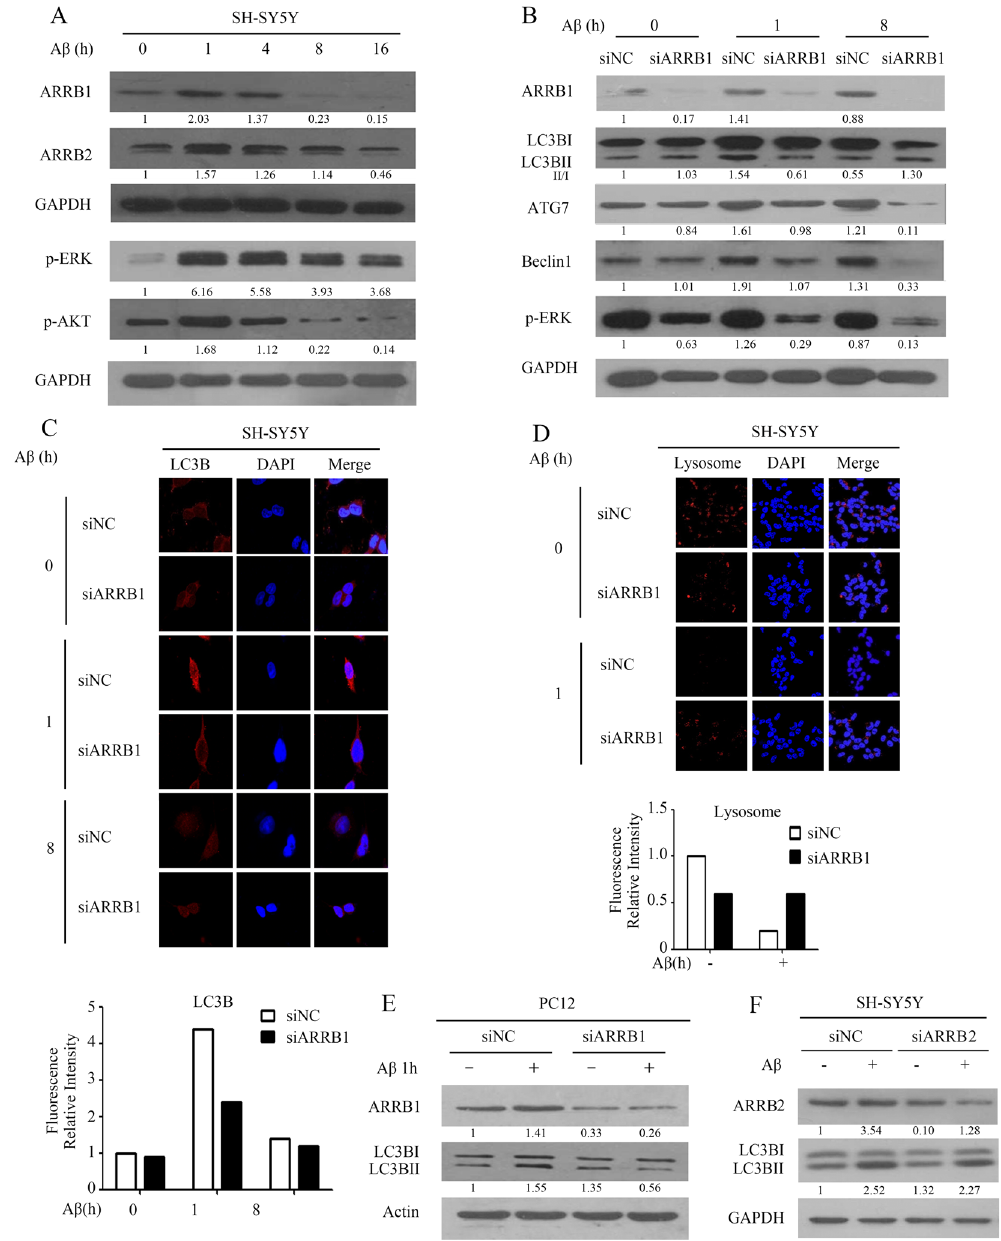
Figure 3. ARRB1 participates in A β 25-35 -induced autophagy in SH-SY5Y cells. ( A ) Cells were treated with 20 μ M A β 25-35 for 0–16 h, and the levels of ARRB1, ARRB2, and two survival markers (phospho-ERK and phospho-Akt) were detected by western blot. ( B ) After depletion of arrb1 , in the presence of A β 25-35 , the expression of ARRB1, autophagy markers (LC3B, Atg7, and Beclin-1) and a survival marker (phospho-ERK) were detected by western blot. ( C ) With arrb1 knockdown, in presence of A β 25-35 , for 1 h, the autophagy marker LC3B was detected by fluorescence staining. The red color indicates immunofluorescence staining of LC3B. The blue color is DAPI, delineating the cell nucleus. The right panel contains the merged pictures. ( D ) With arrb1 knockdown, in the presence of A β 25-35 for 1 h, the lysosome marker LAMP1 was detected by fluorescence staining. The red color indicates LAMP1 expression, and the blue color is DAPI. The right panel reveals the merge of the two images. ( E ) With arrb1 knockdown, in the presence of A β 25-35 for 1 h, LC3B was detected by western blot in PC12 cells. ( F ) With arrb2 knockdown, in the presence of A β 25-35 for 1 h, LC3B was detected by western blot. The raw data of figure A/B/E/F is the figure 3A/3B/3E/3F in supplemental